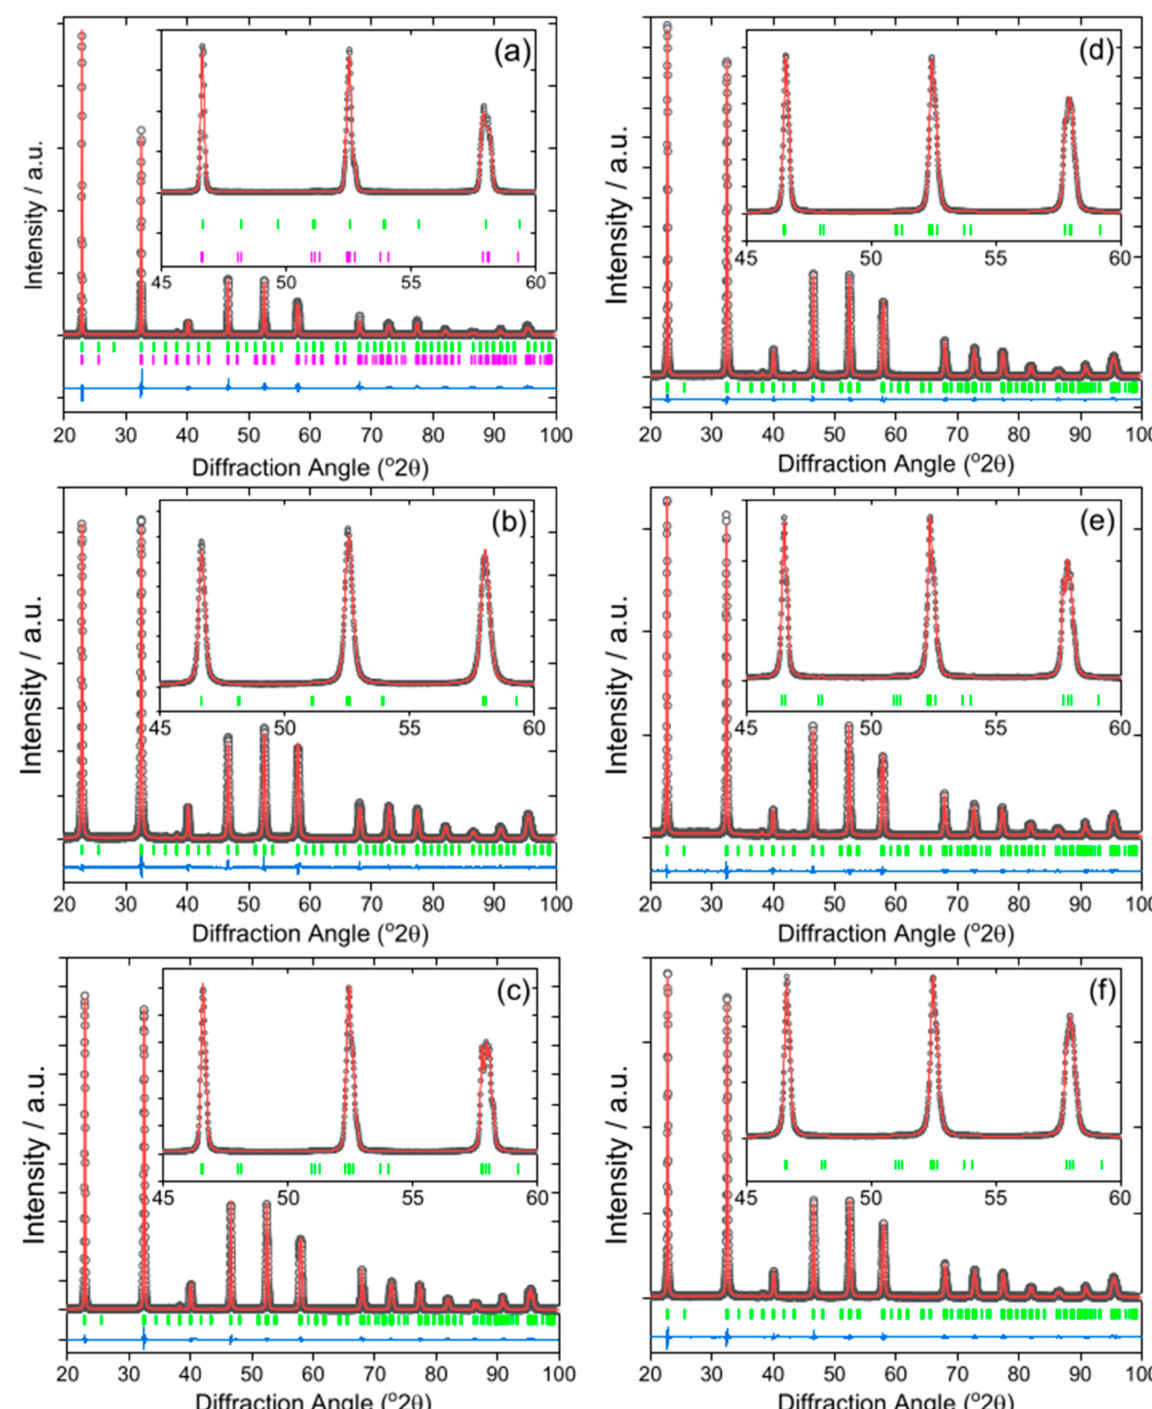
Figure 1. Fitted powder XRD patterns ( λ = 1.5418 Å) of Ir-NaTaO 3 prepared by hydrothermal synthesis with intended Ir content of ( a ) 0% ( R w = 9.787), ( b ) 10% ( R w = 6.070), ( c ) 20% ( R w = 4.969), ( d ) 30% ( R w = 4.767), ( e ) 40% ( R w = 6.089), ( f ) 50 % ( R w = 6.767). The data are the black circles, the red line is the fitted pattern, the blue line isthe difference curve, and the green tick marks are the positions of allowed Bragg reflections (space group, Pbnm ). In ( a ), the second set of pink tick marks are due to the minor Cmcm phase, where a Rietveld fit was used. ( b – f ) are Pawley